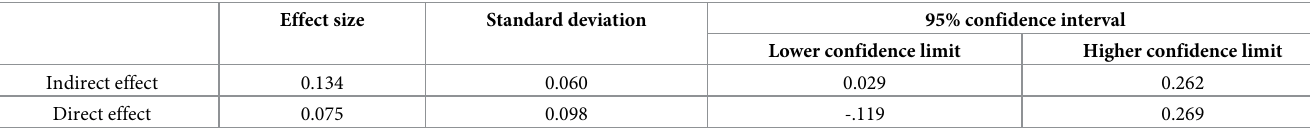
Table 4. Bootstrap test of mediating